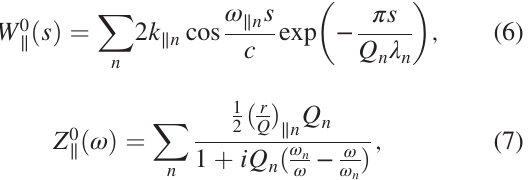
FIG. 4. Longitudinal wake impedances Z 0 ∥ from time-domain and frequency-domain calculations: (a) The longitudinal wake impedance in a symmetric cavity; (b) The longitudinal wake impedance in an elliptical cavity ( a ¼ 1 . 75 b ). The horizontal axis is the normalized frequency kd